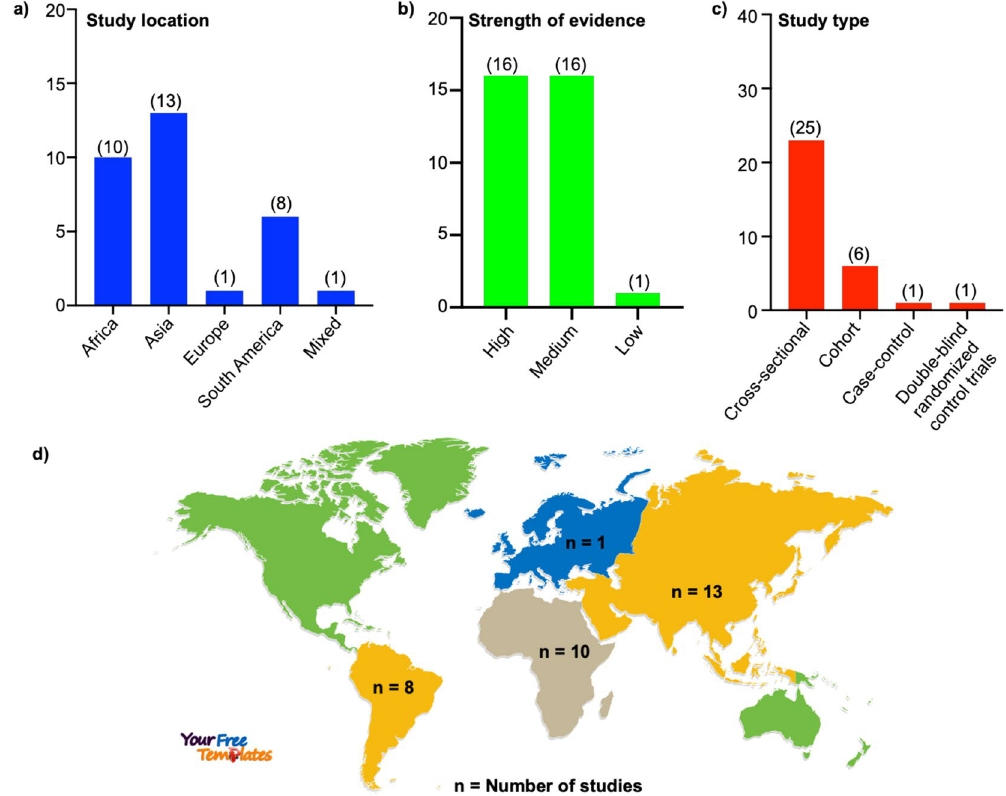
Figure 3. Characteristics of the included studies. (a) Location, (b) quality of the evidence, and (c) type of studies. (d) World map showing the number of studies by continents. The world map was obtained from (https ://yourf reete mplat es.com/) on 17th December